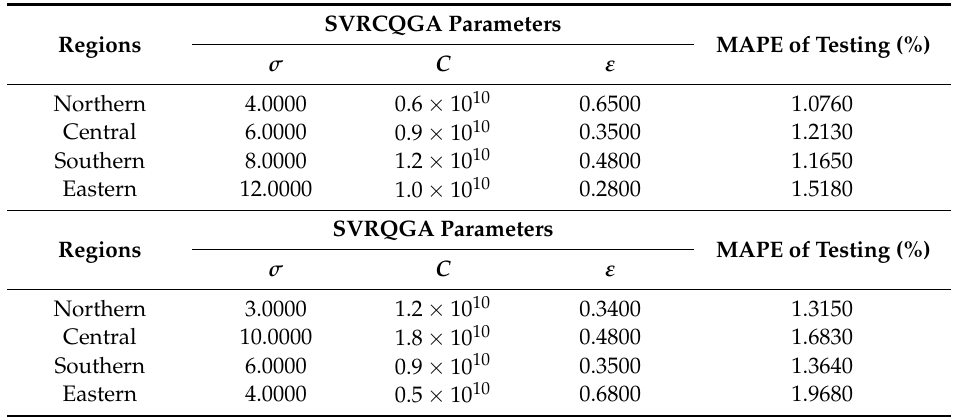
Table 2. Determined parameters of SVRCQGA and SVRQGA models (Example 1).